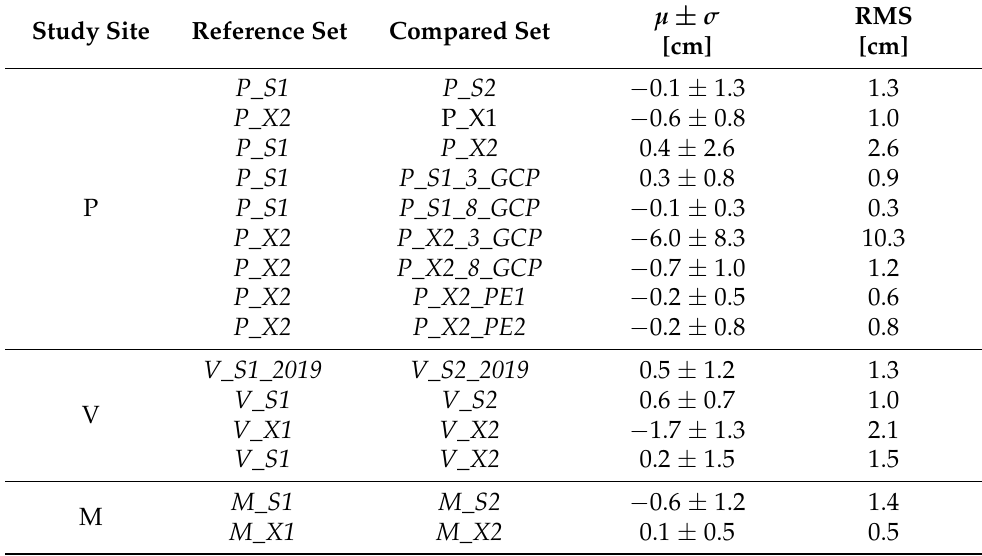
Table 5. Summary statistics of M3C2 distance values for all the compared point clouds. Mean ± stan- dard deviation and RMS are reported (in